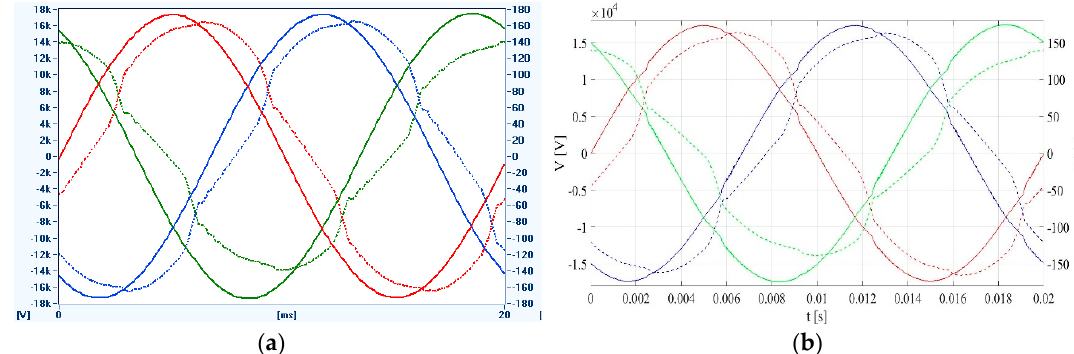
Figure 28. The voltages (full line) and the currents (chain line): ( a ) the measurement; ( b ) the simulation. Energies 2019 , 12 , x FOR PEER REVIEW